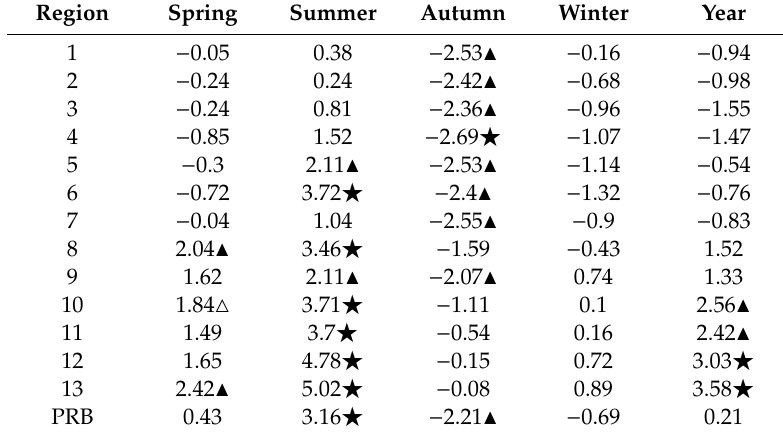
Table 3. M–K values for the ETa in the Pearl River Basin and its sub regions at the seasonal and annual